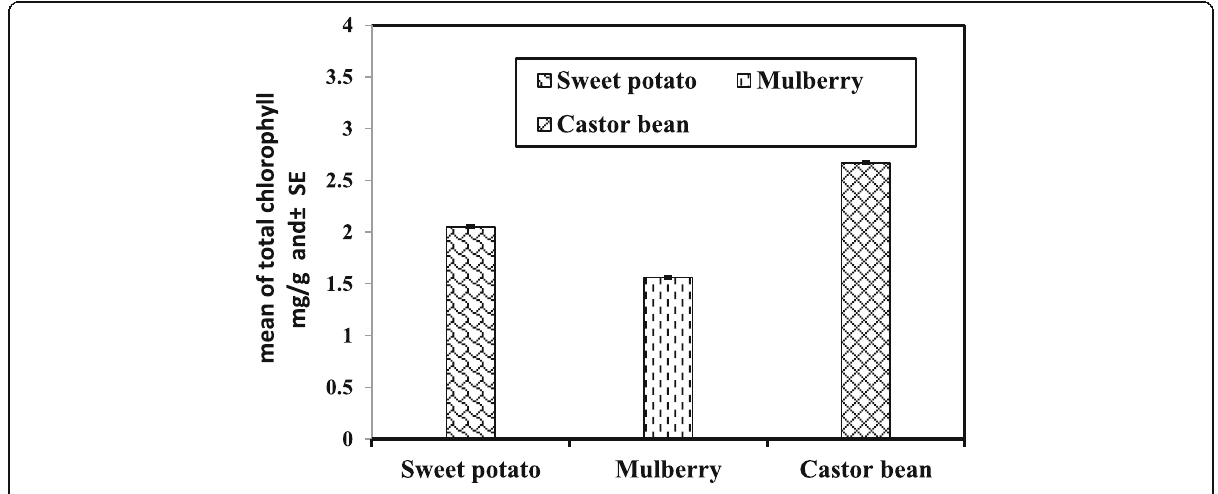
Fig.5 Total chlorophyll in three host plants leaves